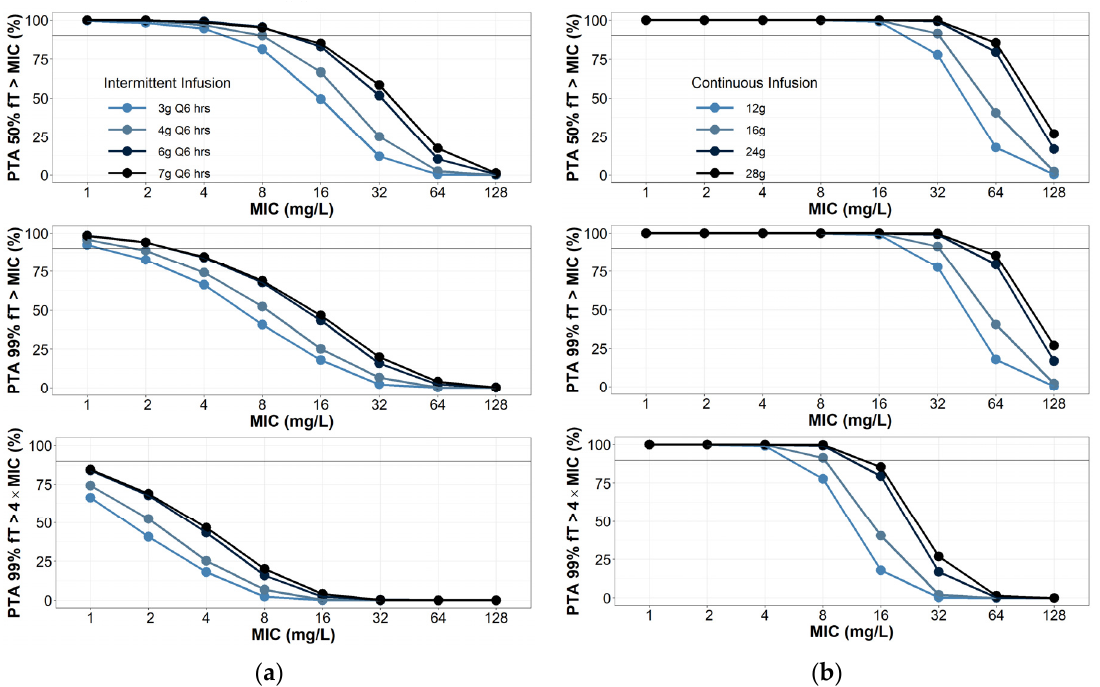
Figure 2. Probability of target attainment for ( a ) piperacillin intermittent infusions; ( b ) continuous infusions. Intermittent infusions assumed to be infused over 30 min. Creatinine clearance was randomly selected between 100 and 130 mL/min, with 1000 virtual patients simulated per dosing group.